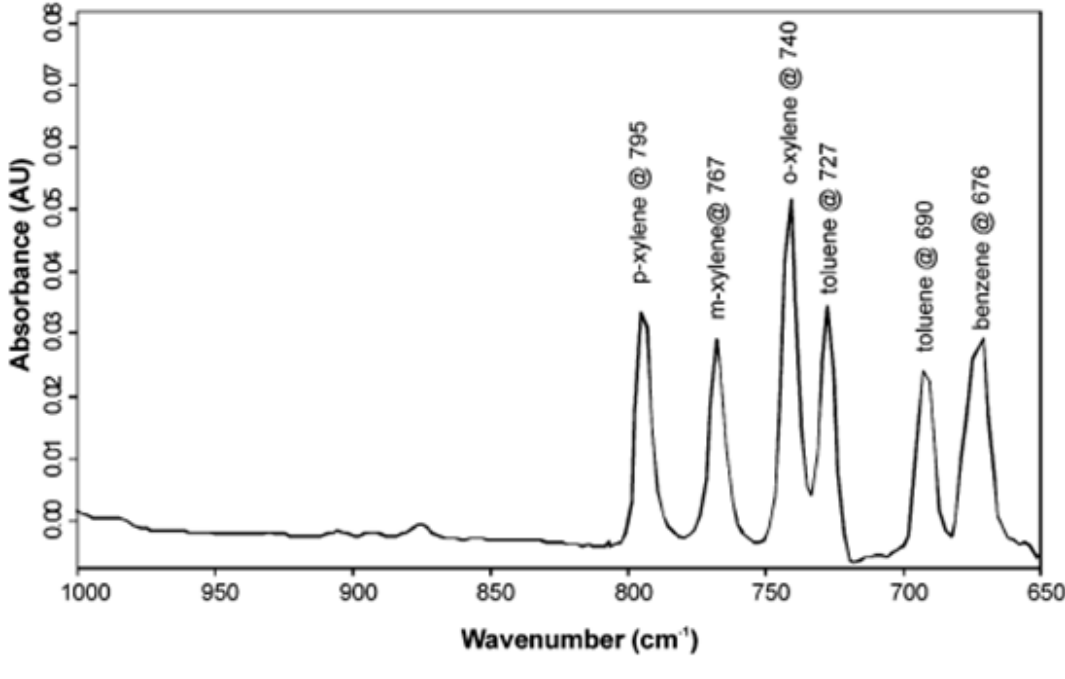
Figure 4. The simultaneous determination of several aromatic compounds by MIR-ATR sensor. Reproduced from [20] with the permission of the American Chemical